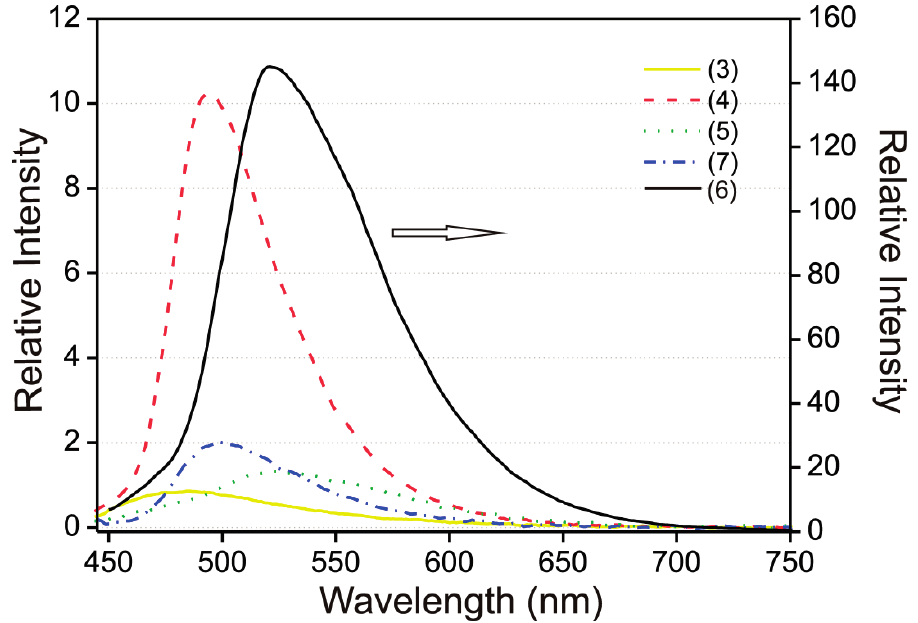
Figure 6. Fluorescence emission spectra of compounds ( 3 – 5 , 7 ) ( left y-axis ) and ( 6 ) ( right y-axis ) 100 μ M in EtOH–H O (95:5 v/v). Excitation wavelength was fixed at the absorption 2 maximum of each compound.